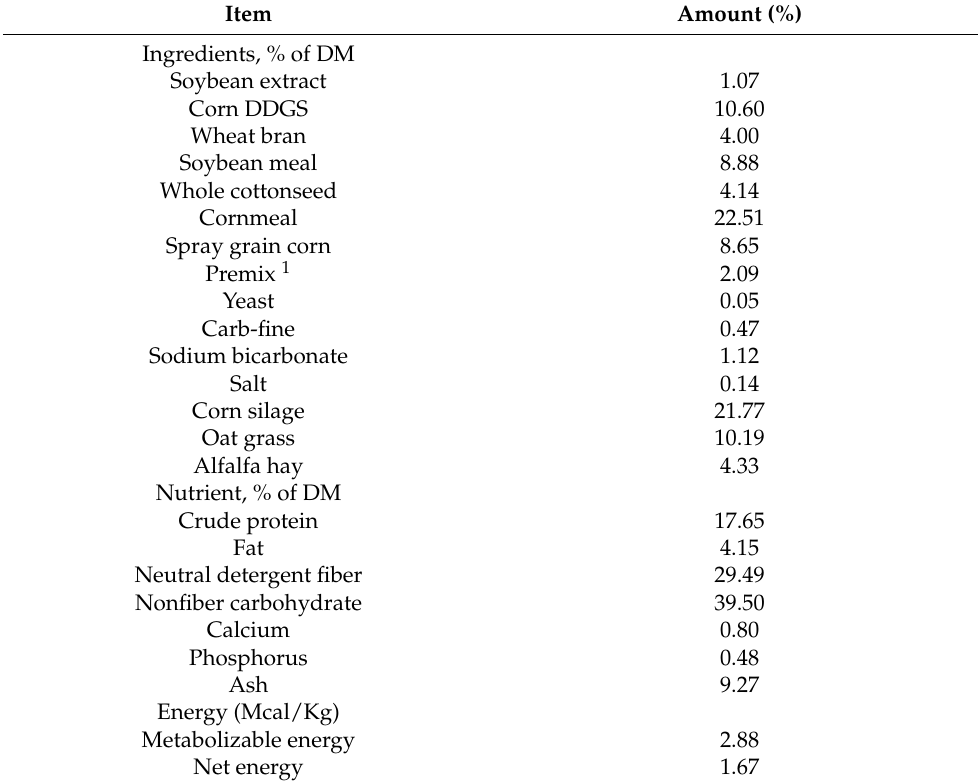
Table 1. Ingredients and chemical composition of the experimental